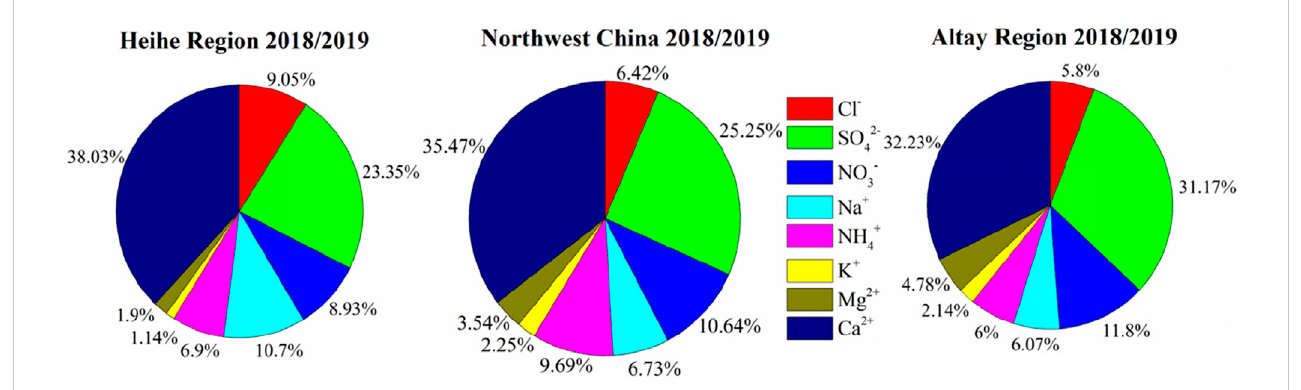
FIGURE 2 The proportion of ion concentration in Heihe region, Altay region and Northwest China region in